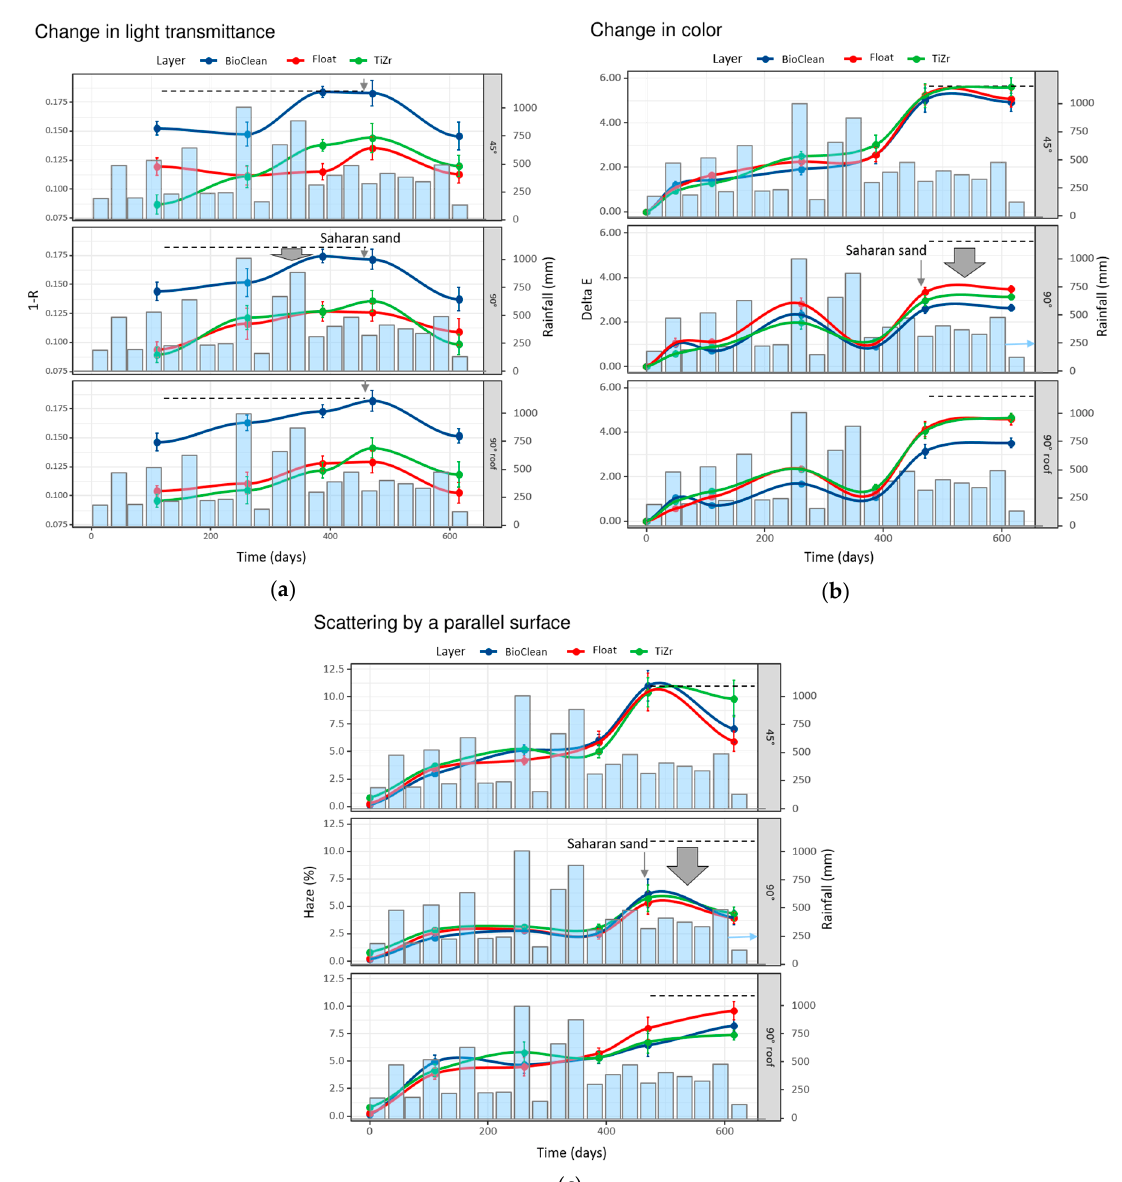
Figure 4. The averaged results from the three locations of field testing of the surfaces; change in light transmittance expressed as 1-R according to lux meter ( a ), changes in ∆ E* values; ( b ) and changes in haze ( c ). The pale blue bars represent the average monthly rainfall in mm across all locations. The dashed lines represent the maximum value as measured in the dataset, and are shown to guide the reader’s eye, and the gray-filled arrow represents the difference from the maximum values (measured at 45° inclination).